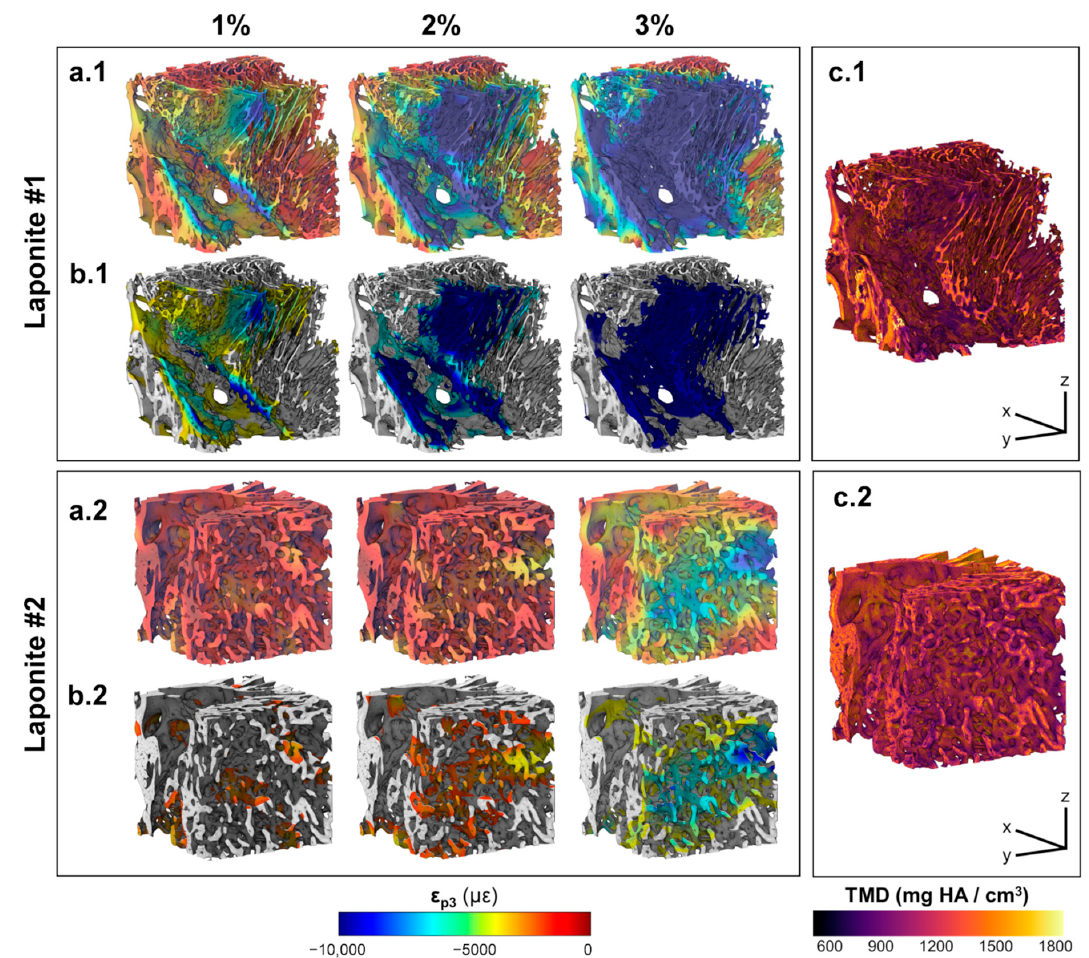
Figure 7. ( a )( a.1 , a.2 ) 3D full-field third principal strain distribution ( ε p3 ) at each compression step for the VOI of Laponite specimens, and ( b )( b.1 , b.2 ) corresponding 20% of the bone volume fraction (BV/TV) that was highly strained. An increase and redistribution in the accumulated strain is observed after consecutive compression steps. ( c )( c.1 , c.2 ) Tissue mineral density distribution in the VOI of each specimen. Highly mineralized regions were found within the woven bone, whereas the newly formed thin trabeculae showed lower mineralization.